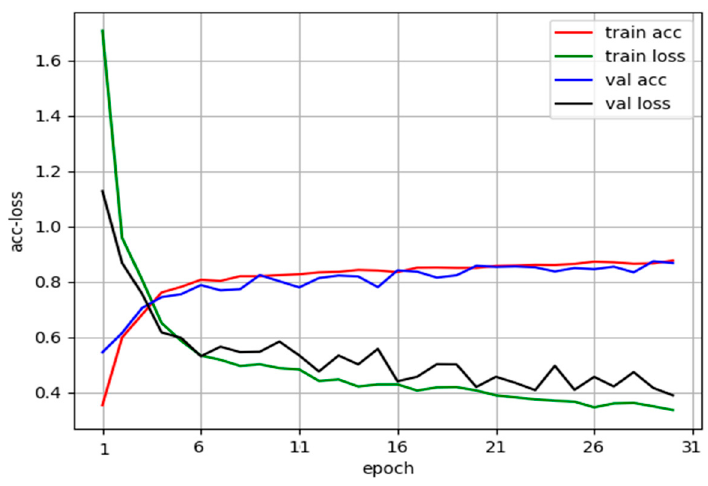
Figure 5. Accuracy and loss in the training. The red and blue curves denote the accuracy of the training set and validation set, respectively. The green and black curves denote the loss of the training set and validation set, respectively. After 30 epochs, the accuracy curves become flat.